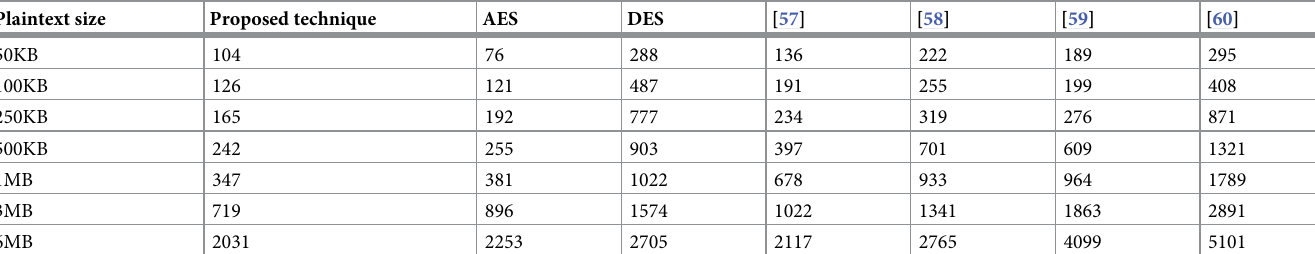
Table 8. The proposed technique efficiency compared to other novel techniques (time in milliseconds). Plaintext